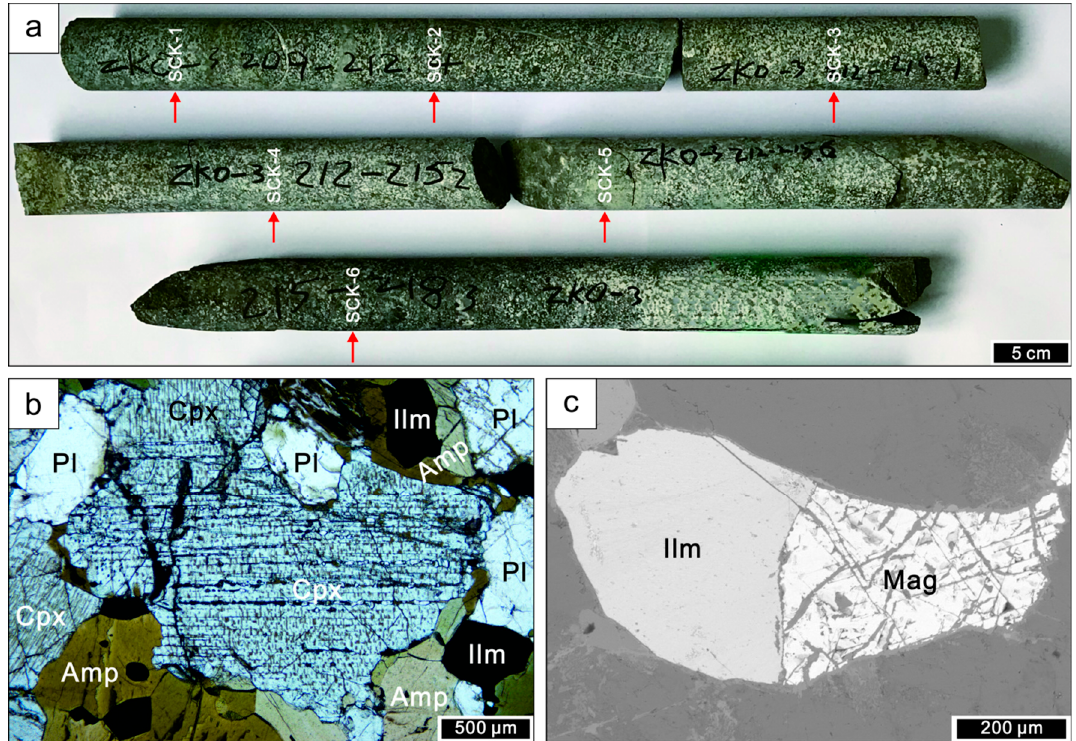
Figure 2. Petrological characteristics of the Sanchakou gabbros from the Jining terrane. ( a ) The Sanchakou gabbro drilling core (The arrows indicate the slicing and sampling positions); ( b ) The main rock-forming minerals, including the diopside, pargasite, and plagioclase; ( c ) The equilibrium assemblage of magnetite and ilmenite. Mineral abbreviations: Amp, amphibole; Cpx, clinopyroxene; Ilm, ilmenite; Mag, magnetite; Pl, plagioclase.